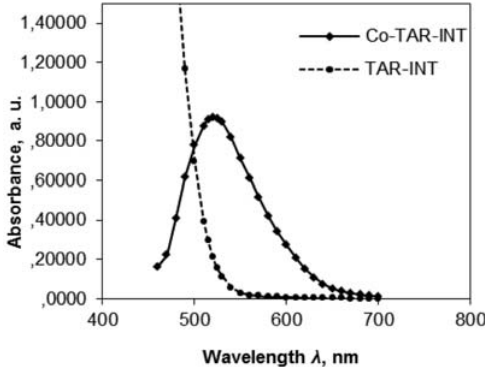
Figure 1. Absorption spectra of the complex Co–TAR–INT and of the blank sample TAR–INT in CHCl 1.8 × 10 –4 mol L –1 ; C